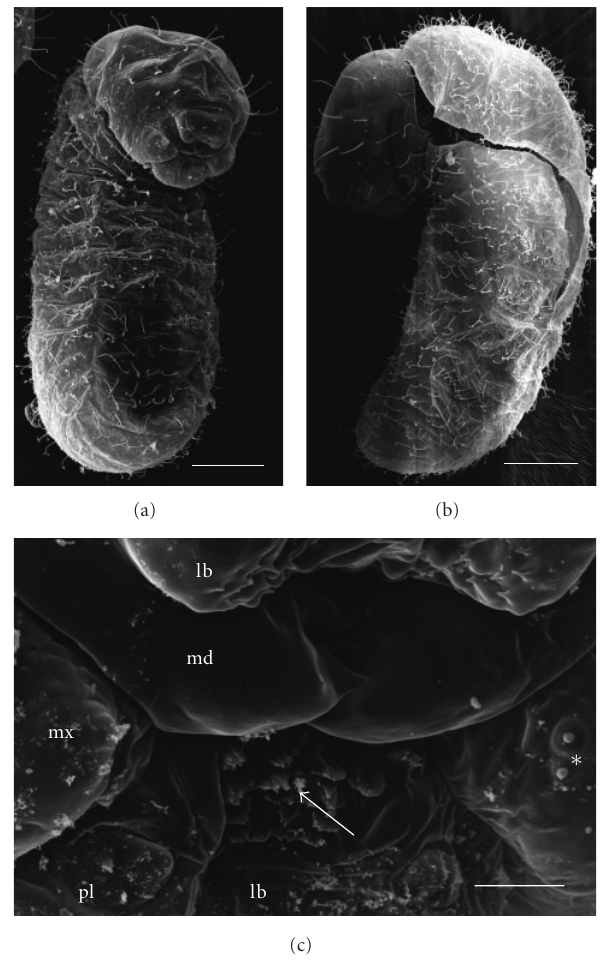
Figure 3: Third instar larva of Solenopsis saevissima . (a) Larva in frontal view. (b) Larva moulting to fourth instar. (c) Mouthparts; lb: labrum; md: mandible; mx: maxilla; lm: labium; arrow: spiny papillae at mouth entrance; asterisk: galea. Respective sizes of scale bars ( µ m): 100, 100, and